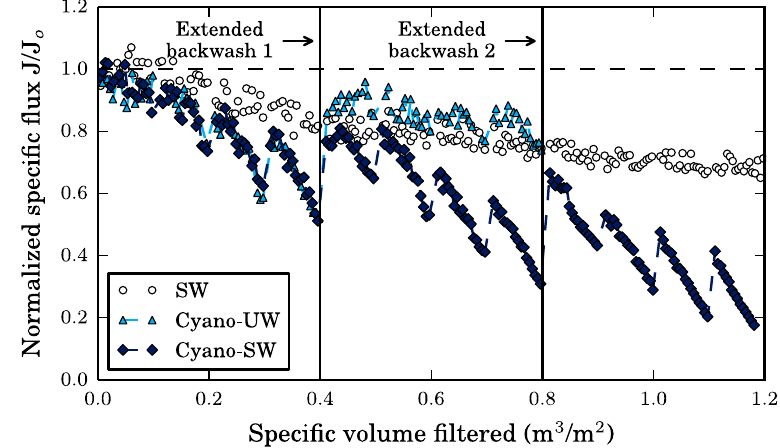
Figure 3. Decrease in the membrane’s specific flux during constant flux, dead-end filtration (200 LMH) of different feed solutions. The horizontal dashed line indicates the clean membrane flux. The Cyano-UW data is almost fully superimposed by the Cyano-SW data. The Cyano-UW data does not extend passed 0.4 m 3 / m 2 , which represents 2 h of filtration, for fear that cyanobacteria cells would start to significantly deteriorate in the unbuffered ultrapure water.